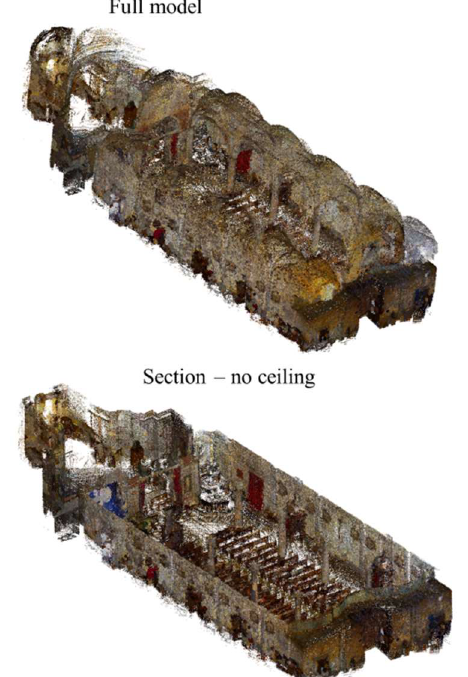
Figure 16. The coloured Stencil 2 post-processed point